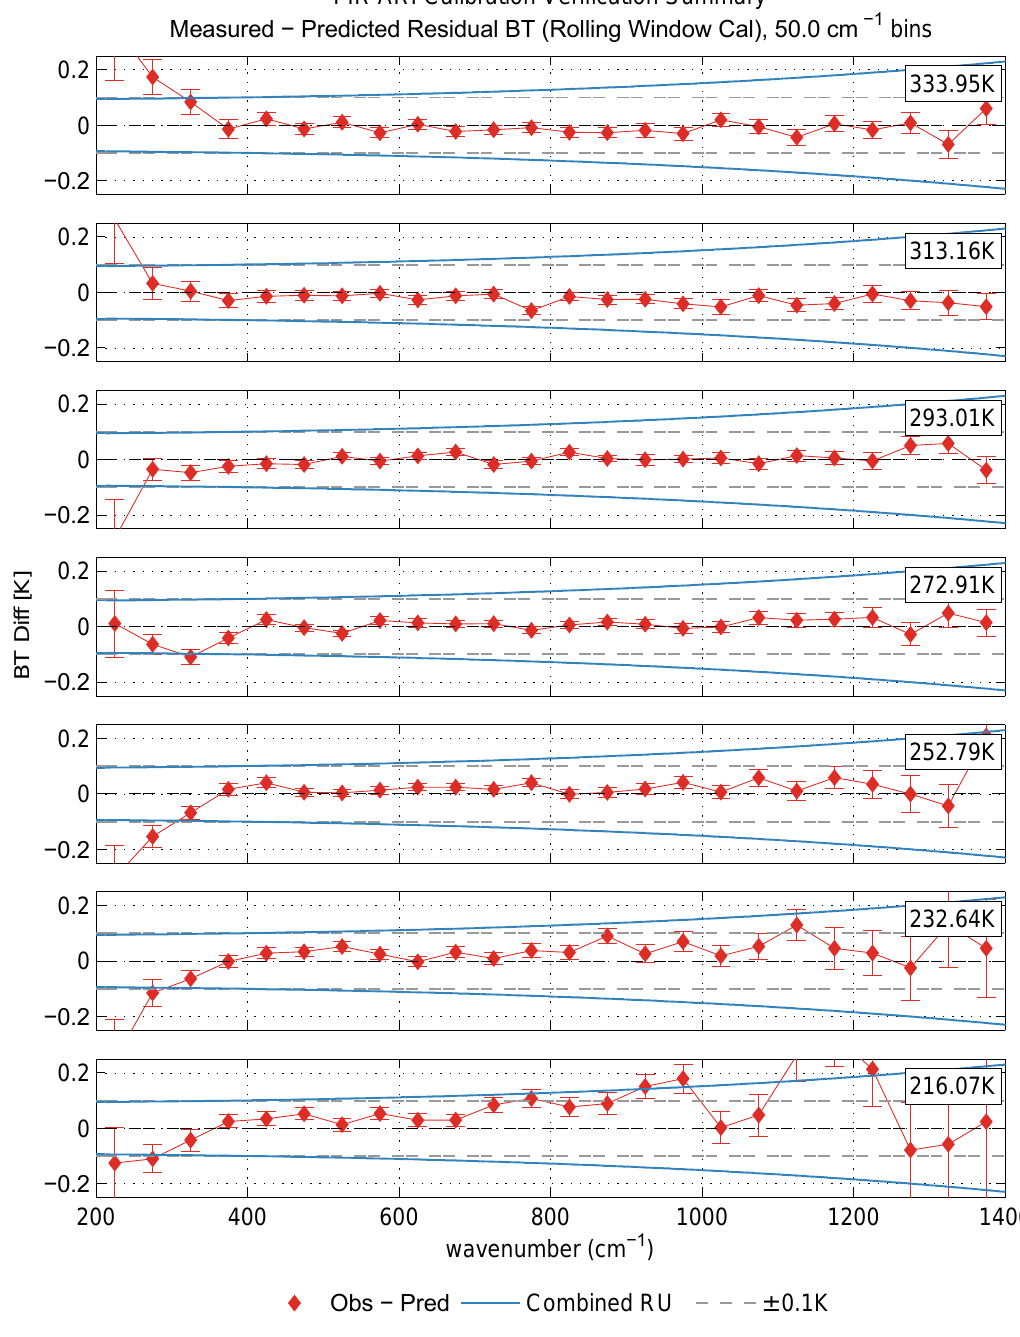
Figure 13. DTGS detector brightness temperature residuals (observed–predicted) for end-to-end calibration verification datasets conducted under vacuum. The results have been spectrally averaged in 50 cm − 1 wide bins for noise reduction. Error bars represent statistical error only (k = 1 standard error). Total (calibration and calibration verification) radiometric uncertainty (k = 3) is shown in blue, and the grey dashed lines indicate ± 0.1 K. The effect of low SNR is evident at the edges of the spectral band.